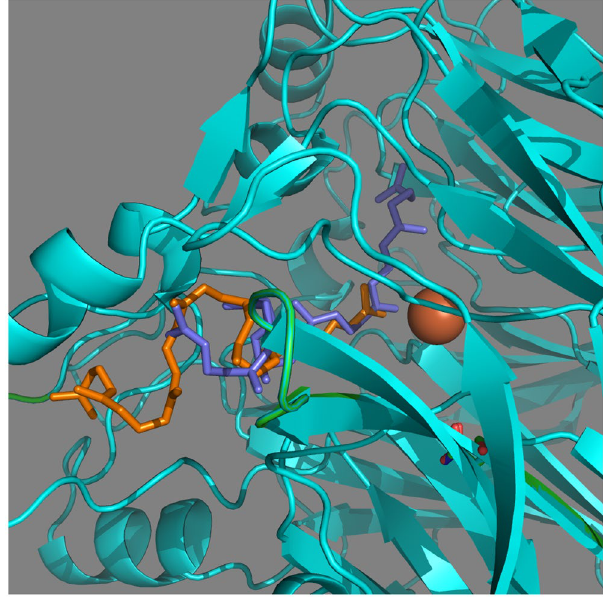
Figure 6. Visualization of lycopene docking on the mBCO2 protein model (lycopene in orange and protein in green) and on the mBCO2SD protein model (lycopene in purple and protein in